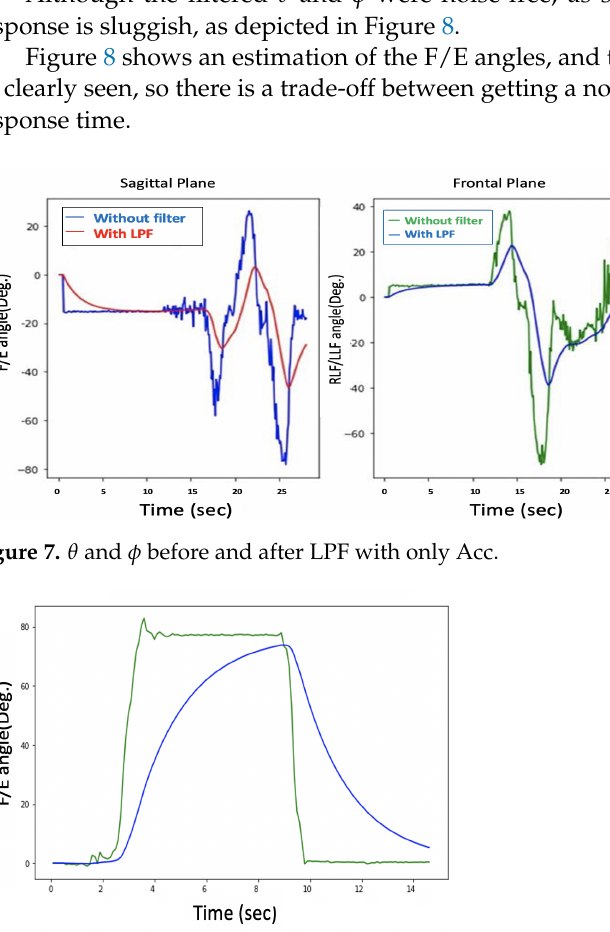
noise and drift contribute to unacceptable